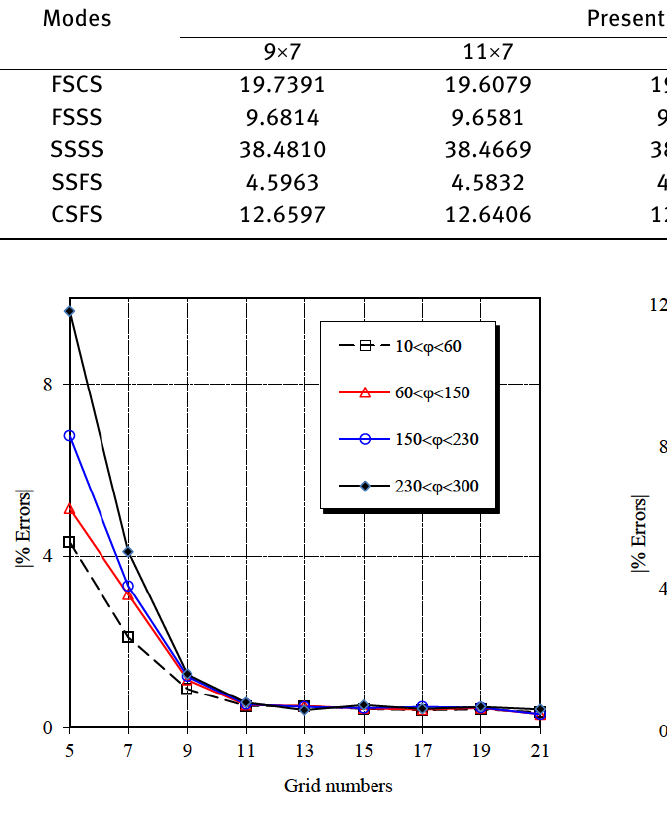
Figure 3: Variation of % errors with grid numbers for different modes and thickness of CCCC annular sector plate ( ϕ =60 0 )